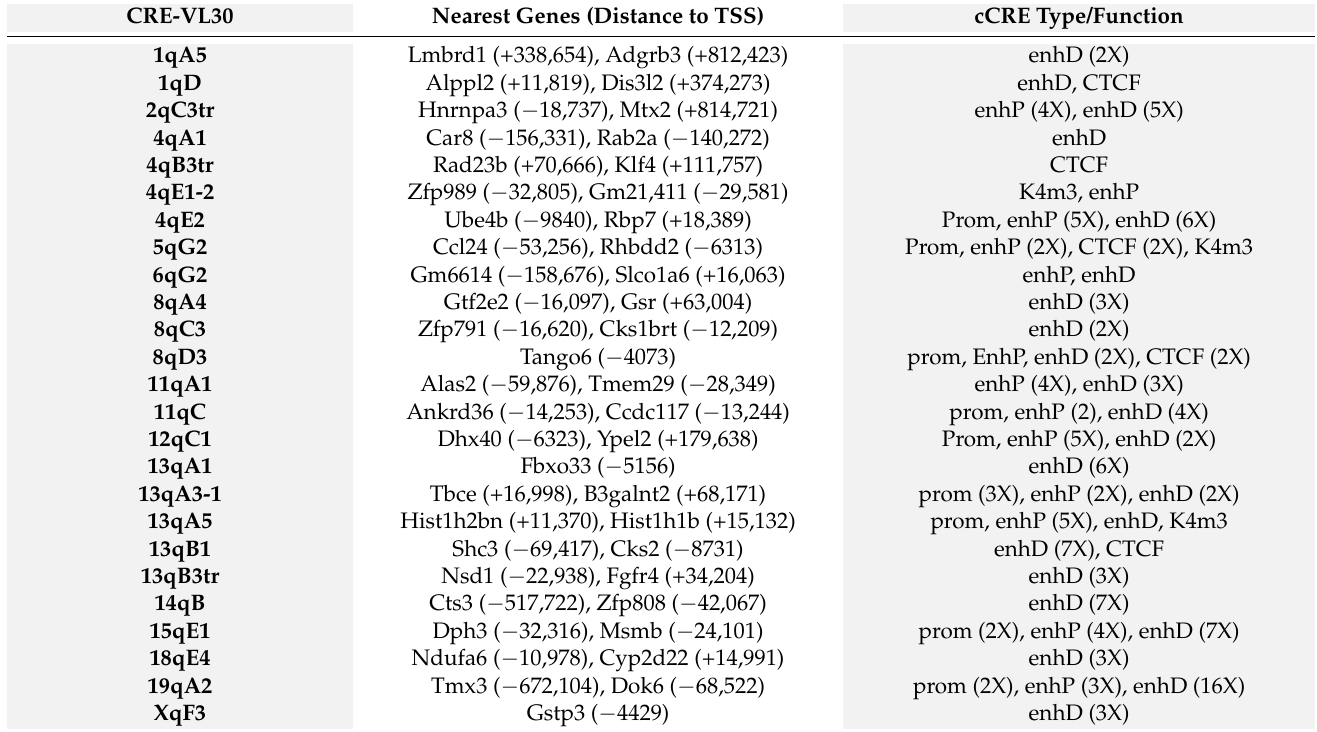
Table 1. CRE-VL30s adjacent to